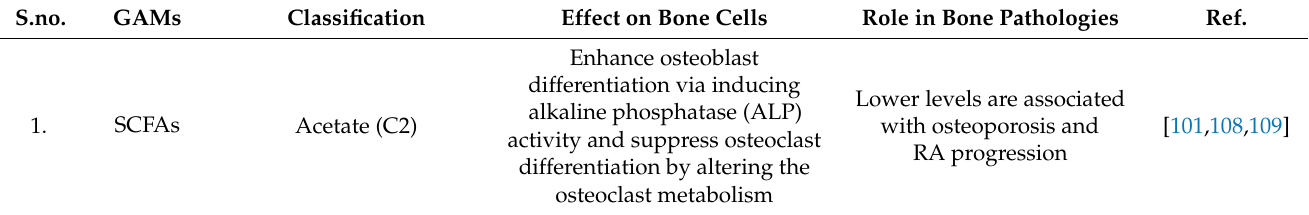
Table 1. GUT Associated Metabolites (GAMs) and their effect on Bone Cell-metabolism. S.no. GAMs Classification Effect on Bone Cells Role in Bone Pathologies